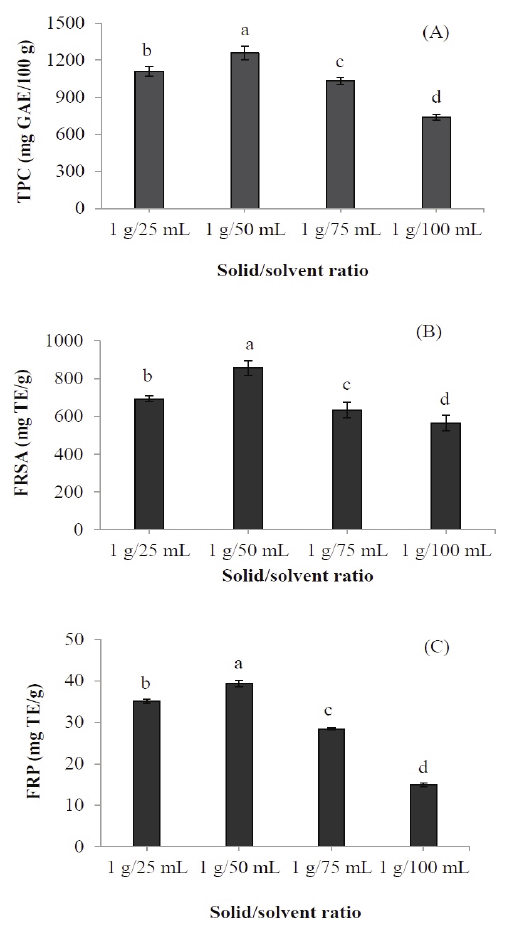
Fig. 3 ­ Impact of the solid to solvent ratio on the extraction effi­ ciency for total phenolic compounds (A), DPPH free radi­ cal scanenging activity (B) and ferric reducing power (C) of eggplant (n= 2). Values with different letters are signi­ ficantly different